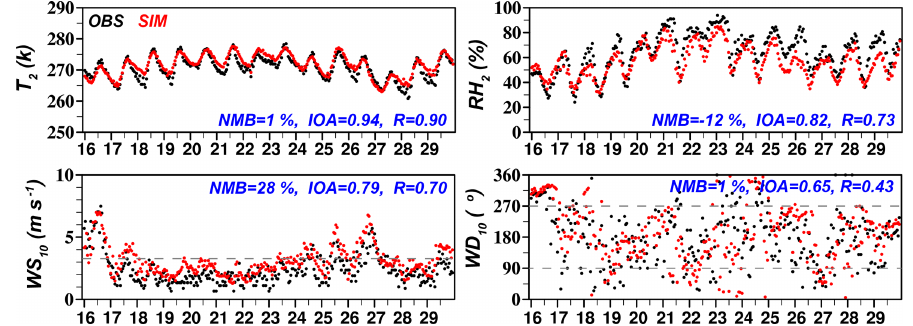
Figure 2. Time series of the observed (black dots) and simulated (red dots) hourly 2m temperature ( T 2 , K), 2m relative humidity (RH 2 , %), 10m wind speed (WS 10 , ms − 1 ), and 10m wind direction (WD 10 , ◦ ) averaged over the 12 stations from 16 to 29 December